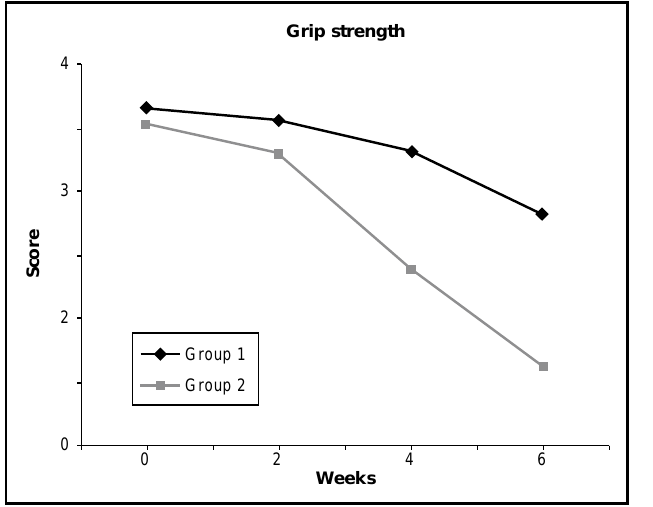
Figure 7: Development of grip strength for the six week-course of treatment in the comparison groups.